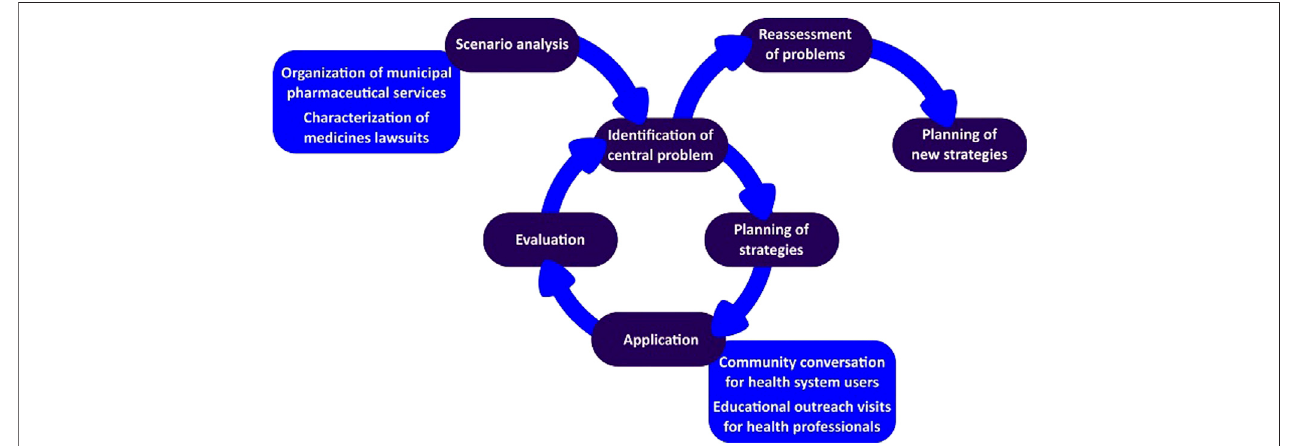
FIGURE 1 | Action research